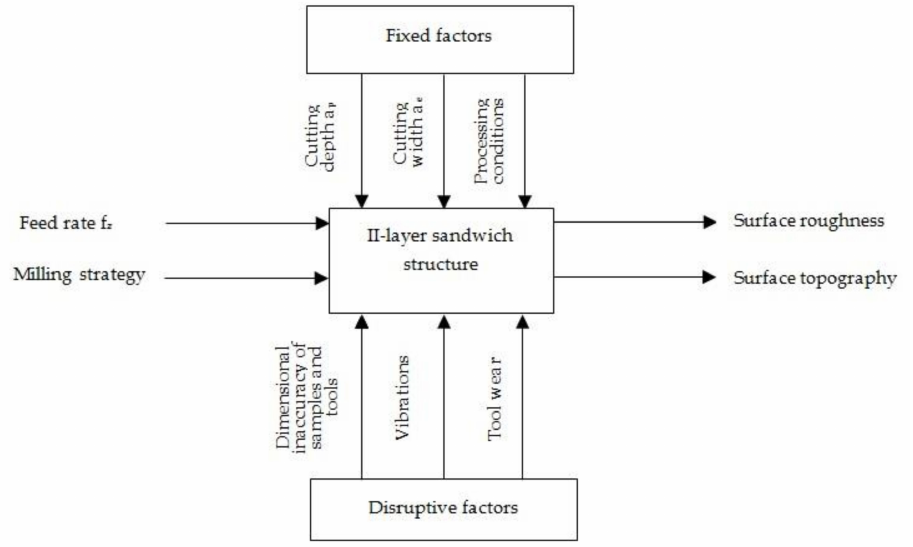
Figure 4. Experiment